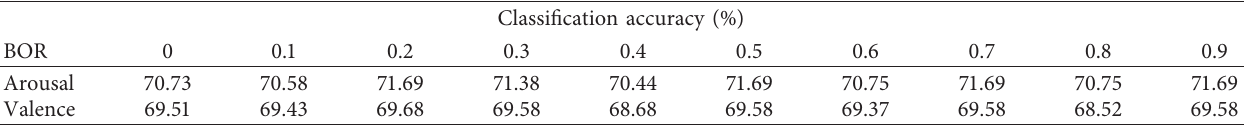
Figure 10: Emotion recognition accuracy with different filter sizes in two dimensions. Given k � 5, 7, 9, and 11, the changes in the 2 recognition accuracy from varying the size of filters in the first layer ( k ) at an interval of 2. (a) Recognition accuracy in arousal dimension 1 with different filter sizes. (b) Recognition accuracy in the valence dimension with different filter sizes. Table 1: Emotion recognition accuracy from different block overlap ratios in the two dimensions.